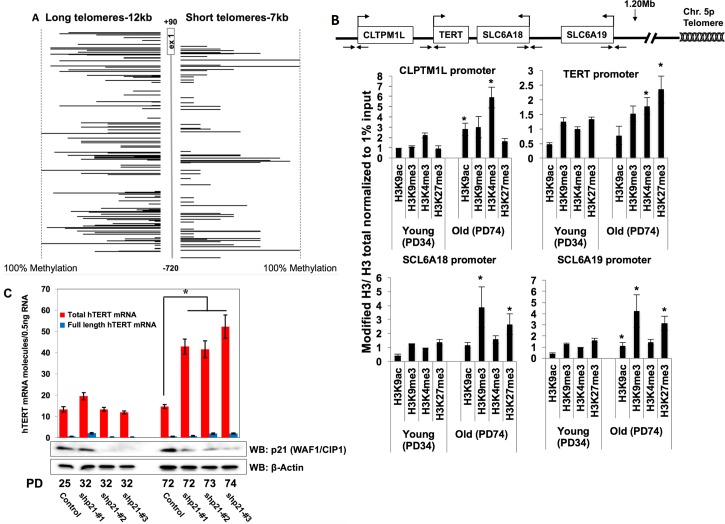
Chromatin looping and epigenetic modifications (i.e., histone modifications and DNA methylation) determine permissiveness of the hTERT locus.(A) Bisulfite DNA methylation sequencing analysis of the hTERT proximal promoter region from -720bp to +90bp. Genomic DNA of BJ clones with different lengths of telomeres was modified and PCR-amplified. Each amplicon was TA-cloned for bacterial amplification and sequenced. Percentage of CpG methylation of the hTERT promoter is indicated in two BJ cell clones with different lengths of telomeres. (B) Illustration of genomic locus containing TERT. Black arrows indicate approximate location of primers in the promoters of the indicated genes. Chromatin immunoprecipitation was performed with BJ cells at PD34 and PD74. Six antibodies against H3K4me3, H3K9ac, H3K9me3, H3K27me3, H3 total, and IgG were used to pull down chromatin extracts, and the promoter regions of hTERT, SLC6A18, SLC6A19 and CLPTM1L were analyzed by ddPCR. Data are presented as means and standard errors of biological and technical duplicates. Student’s paired t tests comparing young and old determined significance (* = p < 0.05). (C) BJ cells at different PDs were infected with shRNAs against p21 (CDKN1A) and selected using puromycin to generate stable knockdown clones. hTERT mRNA expression was analyzed by ddPCR in sh-p21 cells and controls. The number of full-length and total hTERT mRNAs was assessed by amplifying the hTERT exon 7/8 junction and exon 15/16 junction, respectively. Knockdown efficiency of p21 was determined by western blotting. β-actin was used as a loading control. ANOVA revealed a significant effect. *p < 0.001. Data associated with this figure can be found in the supplemental data file (S1 Data).